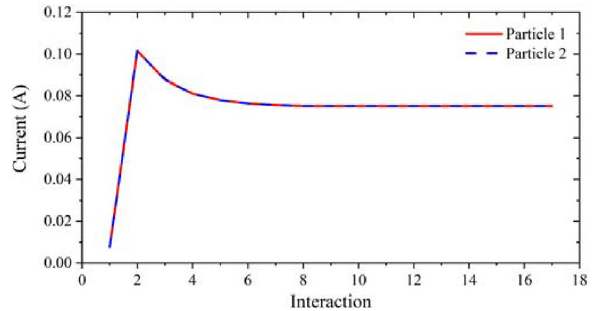
Figure 18. Simulation of the beam current under the uniform magnetic focusing system.